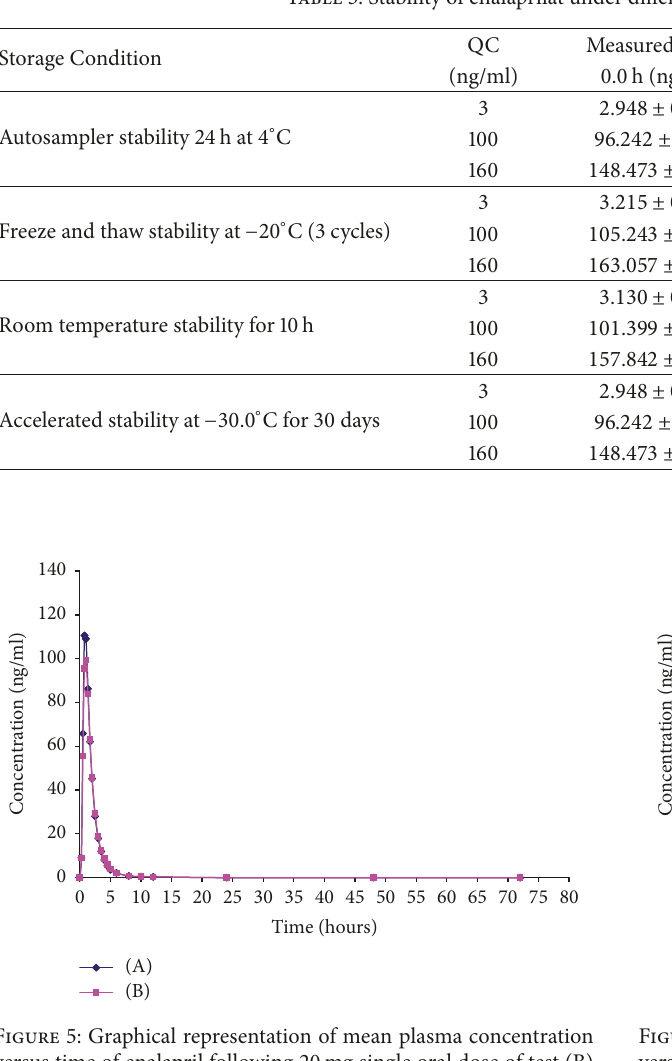
Table 5: Stability of enalaprilat under different storage conditions ( 𝑛 = 6 ).